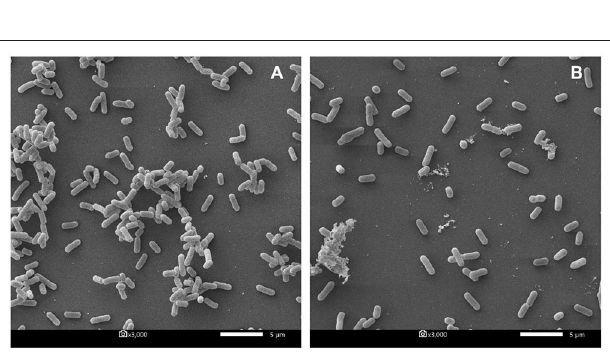
FIGURE 5 | Scanning electron micrographs of biofilm formed by E. coli P01 in sessile stage with different conditions. (A) Represents E. coli cultured into sterile MRS broth for 24h. (B) Represents 24 h-biofilm of E. coli after exposure to non-neutralized CFS of L25F for 2h. Scale bar is 5 µ m, and magnification is